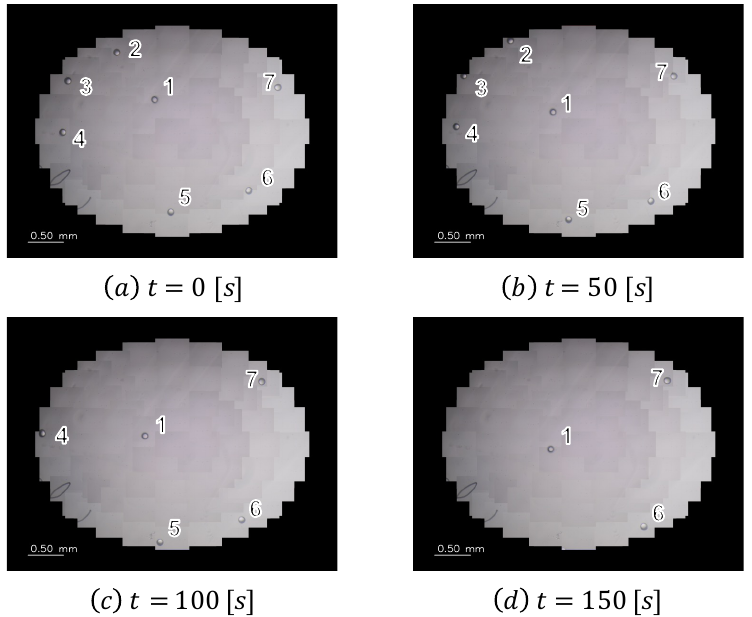
Figure 7. Large field-of-view